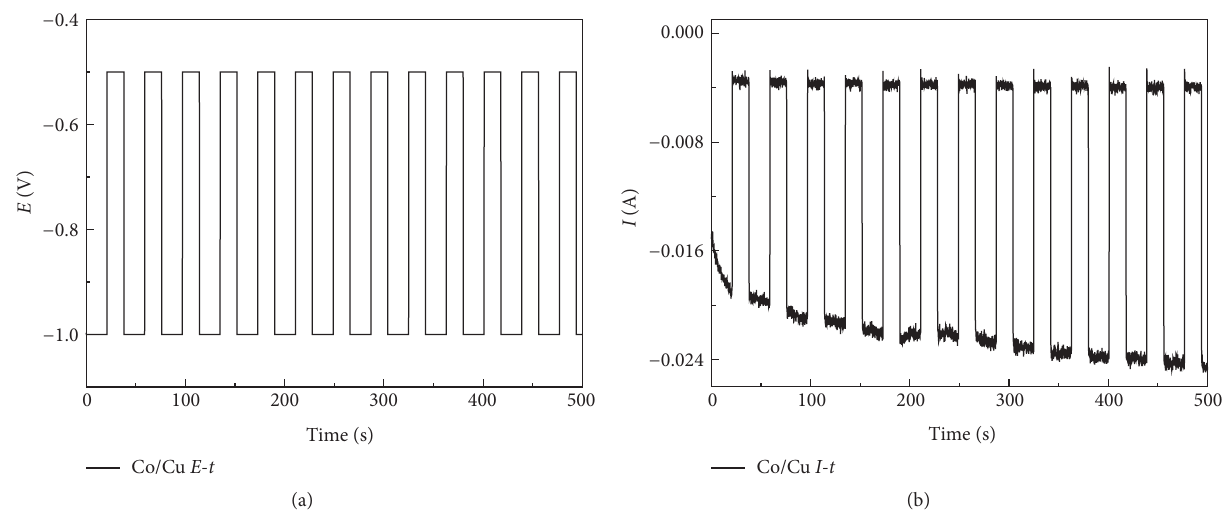
Figure 2: (a) Typical E-t curve recorded during the Co/Cu nanowires electrodeposition process. (b) The dependence of the observed current and time during the nanowire electrodeposition